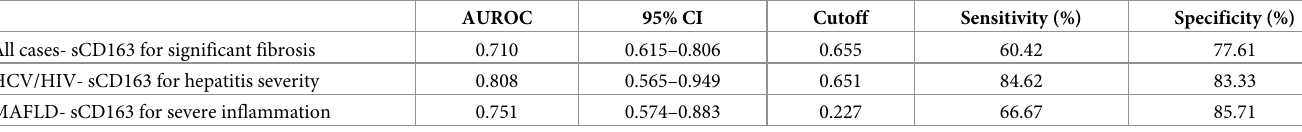
Table 2. Diagnostic accuracy of sCD163 to determine histological